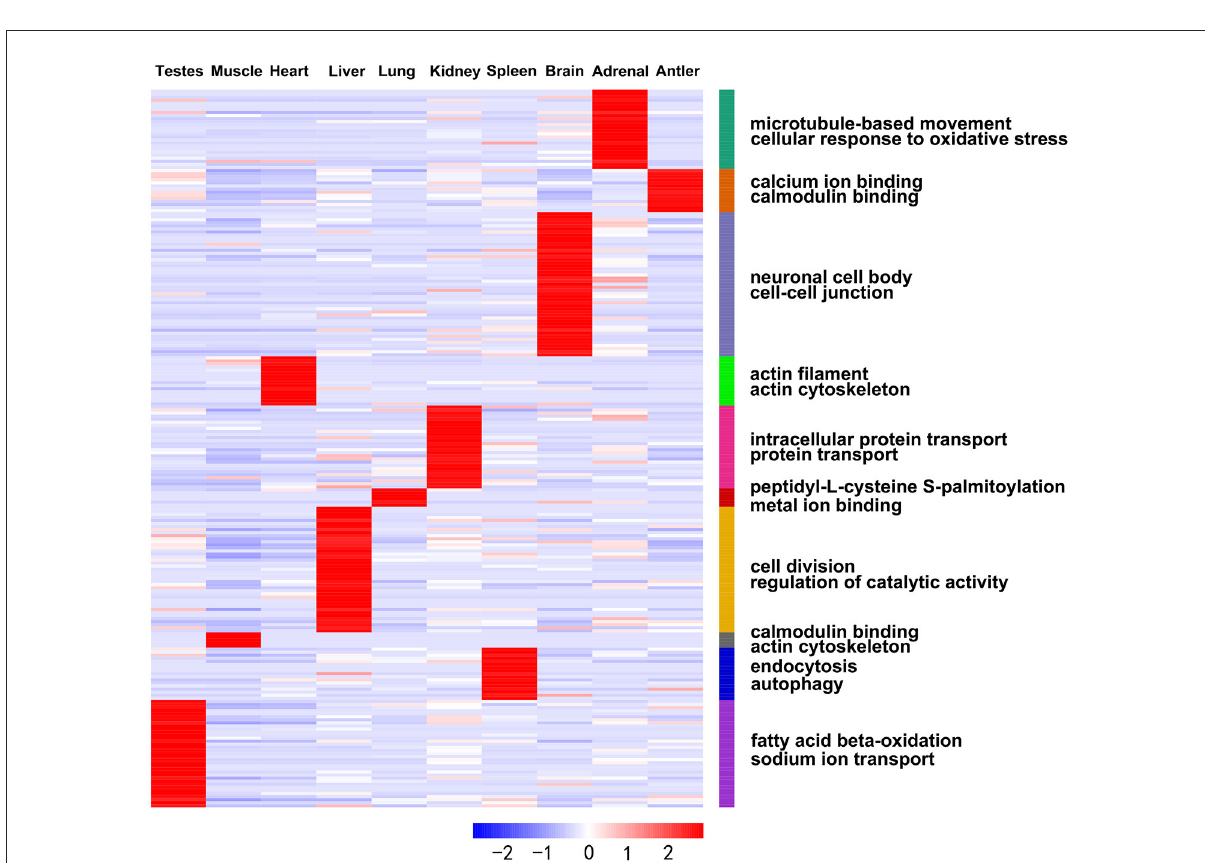
FIGURE4 Heat map showing expression profiles of the organ-enriched miRNAs and their target genes with significant GO annotations using the DAVID functional annotation tools.